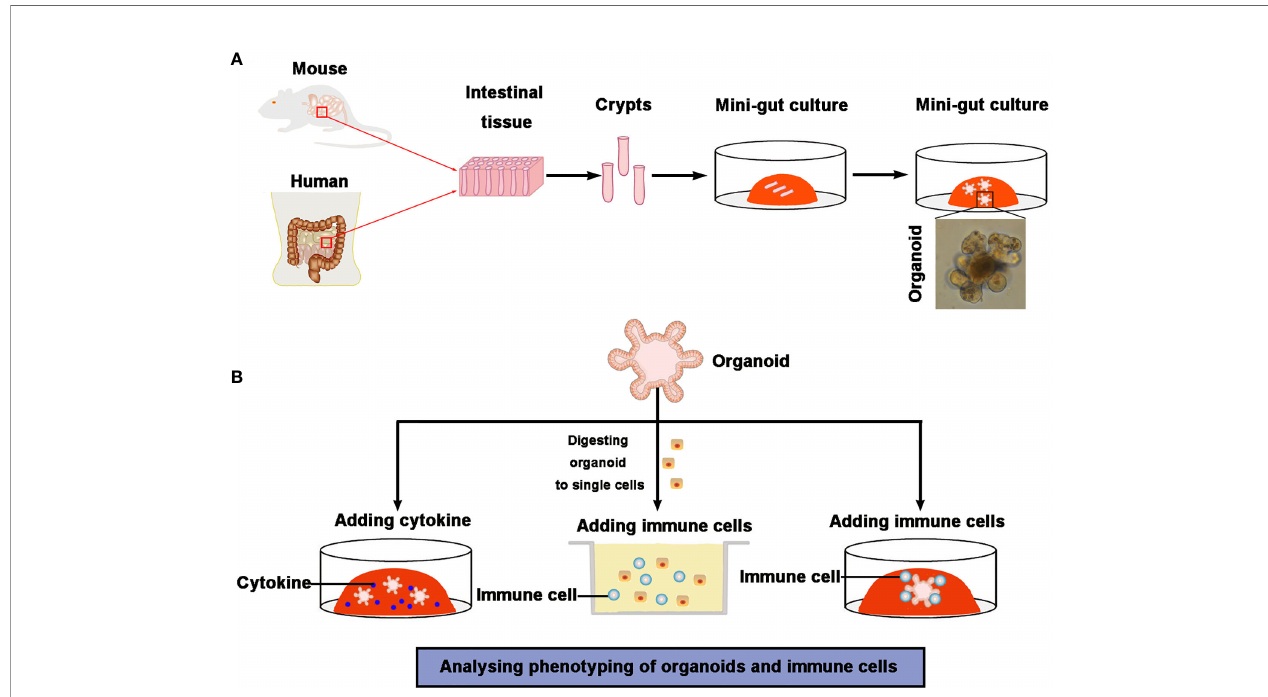
FIGURE 3 | Intestinal organoid – immune cell co-culture models. (A) Crypts are isolated from the intestinal tissue and then embedded into Matrigel with culture medium. Intestinal organoids are formed by crypts. (B) Several intestinal organoids and immune cells and/or cytokines co-culture systems have been established. Treatment of organoids with cytokines is used to estimate the effect of immune cell-derived cytokines on intestinal epithelial cells (especially ISC). Organoids are digested to single cells and then co-cultured with immune cells, which is used to assess the interaction of immune cells and epithelial cells. The addition of (activated) immune cells, such as innate lymphoid cells or T cells, to complete organoids is used to estimate the interactions between epithelial cells and immune